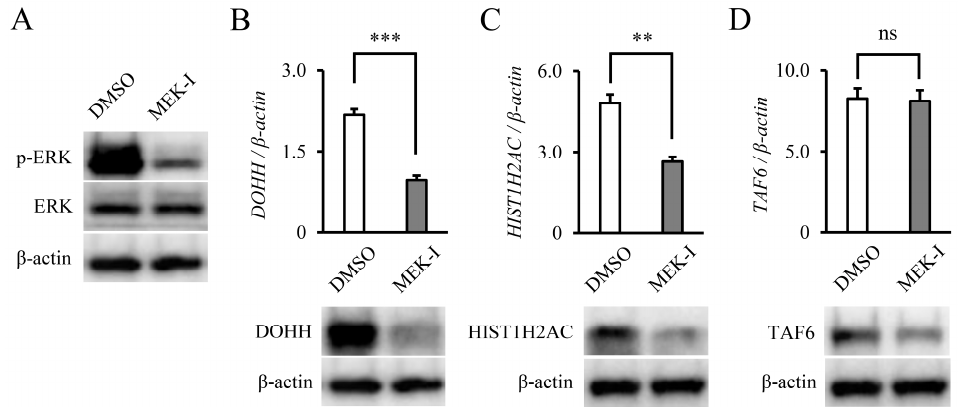
Figure 5. DOHH, HIST1H2AC, and TAF6 are located downstream of ERK. ( A ) After THP-1 parental cell lines had been treated with DMSO or MEK-I (PD184161, 5 µM) for 48 h, ERK and phosphorylated ERK expression were analyzed by WB. ( B – D ) Similarly, mRNA expression ( upper panels) and protein expression ( lower panels) of DOHH, HIST1H2AC, and TAF6 were analyzed. Data are expressed as mean ± SD. Statistical significance was determined using an unpaired t -test. ** p < 0.01, and *** p < 0.001. ns: no significance.